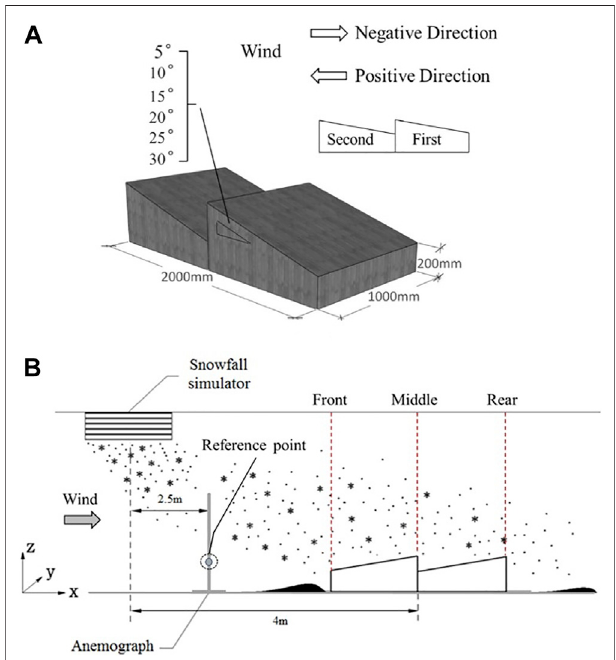
FIGURE 8 | Schematic view of the building model (A) and the experiment setup in the snow-wind combined experiment facility (B) .